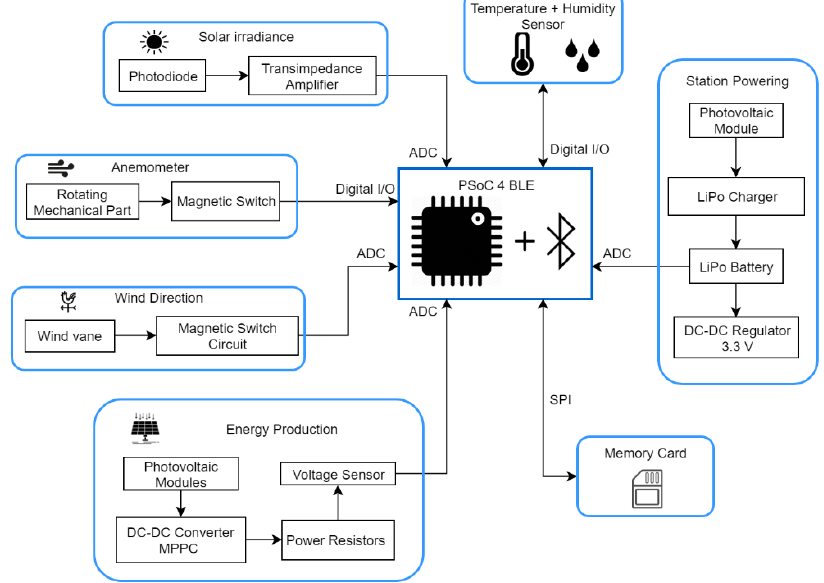
Figure 3. Block diagram of the hardware used in the weather